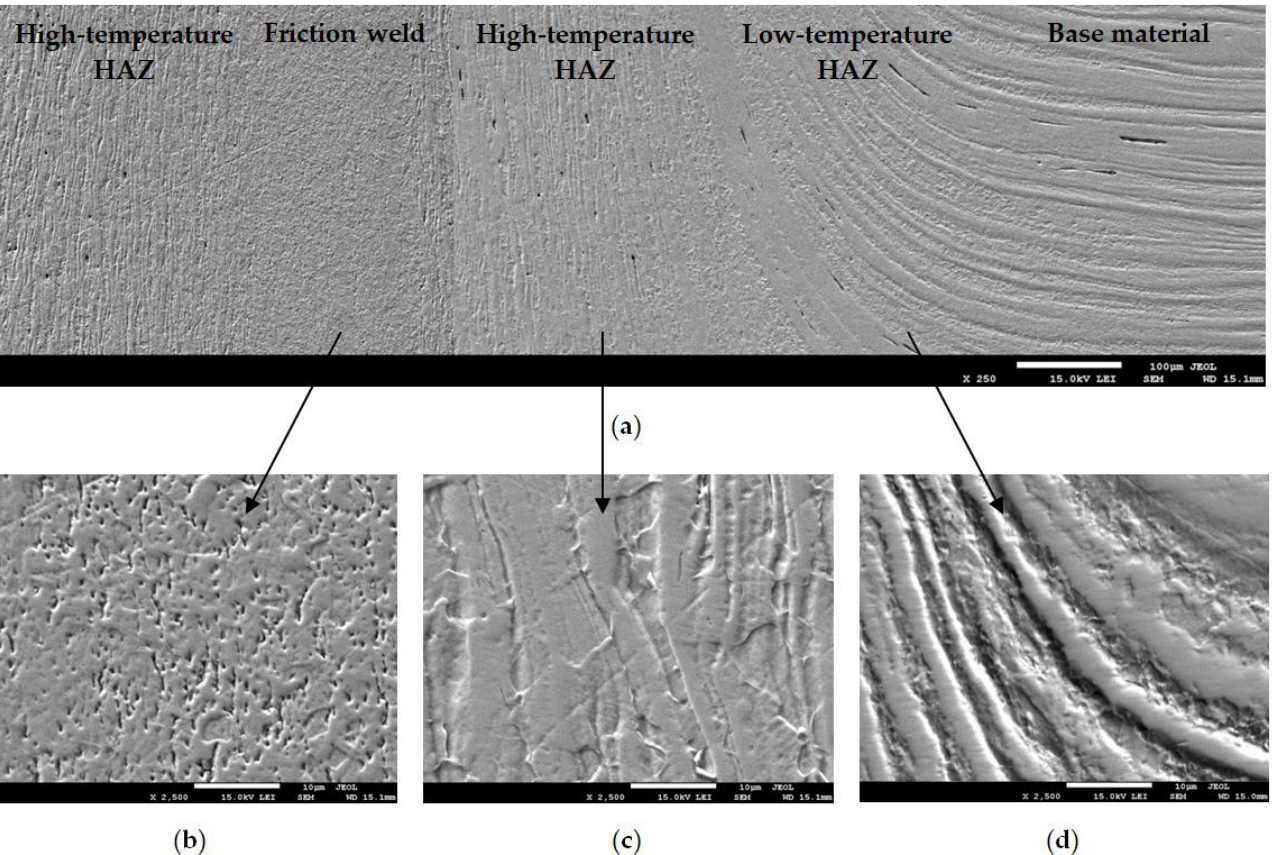
Figure 5. Microstructure of the transverse cross-section of friction-welded joint of UFG 316L steel. SEM-observation in the LEI mode: ( a ) mag. × 250, ( b – d ) mag. × 2500, of friction weld, high- and low-temperature HAZ, respectively.